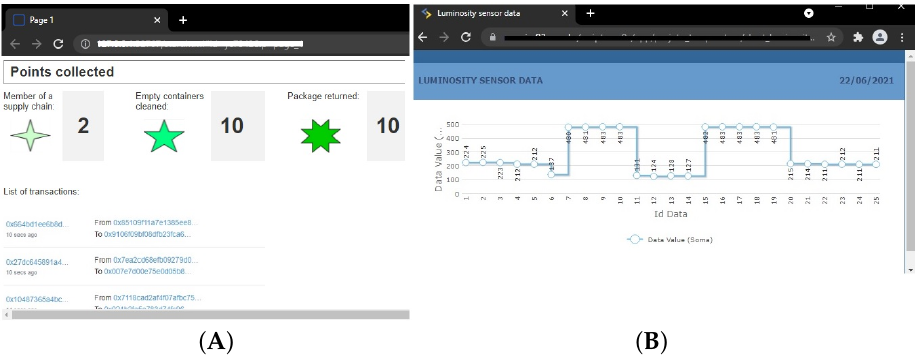
Figure 12. Visualizations: ( A ) points from gamification and ( B ) sensor